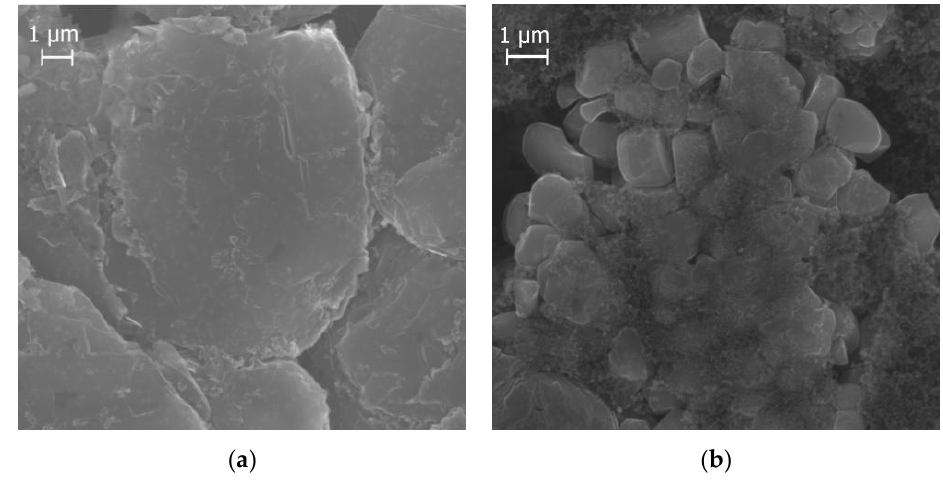
Figure 2. SEM images of ( a ) the negative electrode and ( b ) the positive electrode.